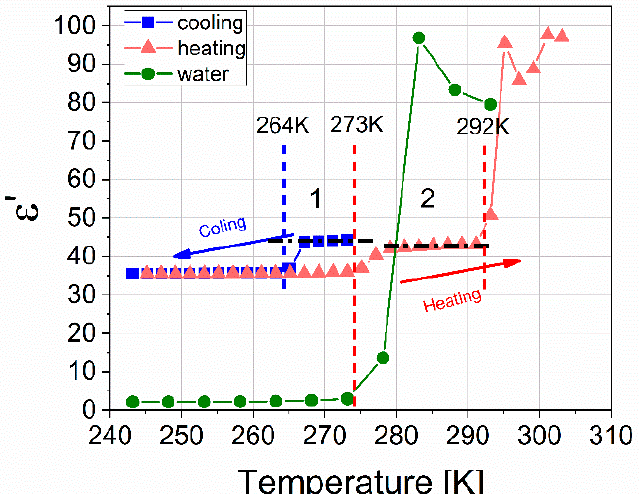
Figure 10. Temperature dependence of ε ‘( Т ) for a mixture of hydrate and ice obtained at 273 K and a pressure of 9 MPa, with a cutoff frequency of 100 kHz. Cooling of the resulting mixture in the first cycle is marked with blue symbols; the heating of the mixture in the fifth cycle is shown with red symbols. Green symbols show ice heating at atmospheric pressure.